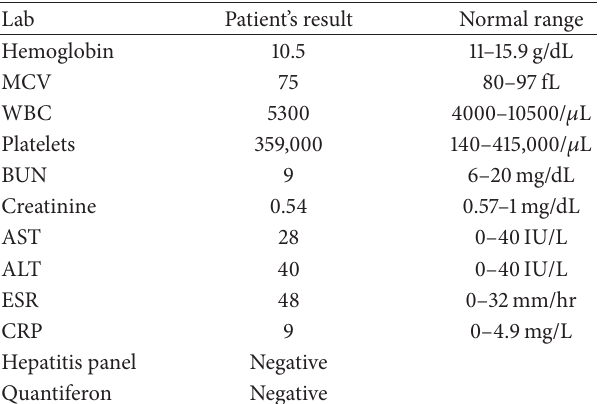
Table 1: Labs at the initial